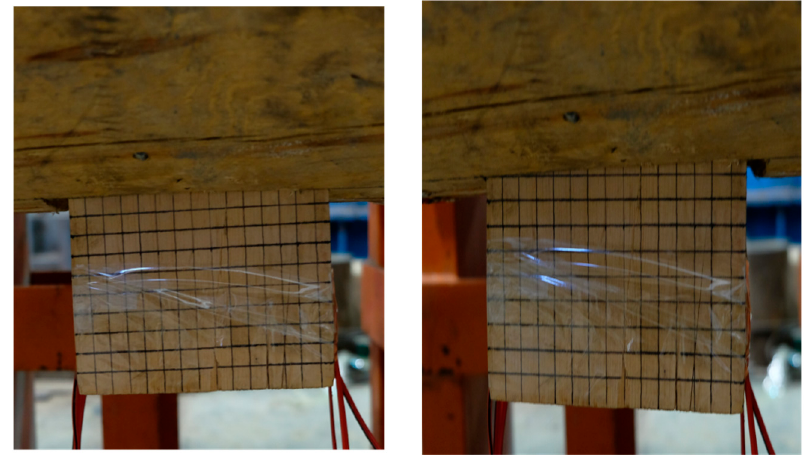
Figure 17. Slipping of the tenon.